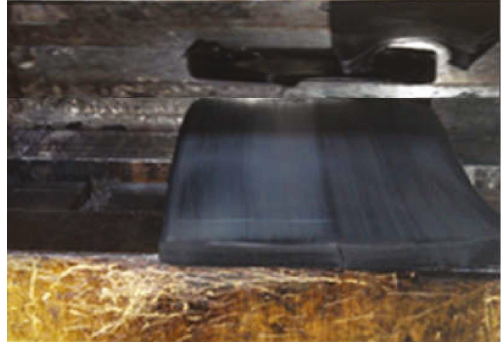
Figure 10: Extrusion state of rubber using optimal runner at 110 ° C and at 0.000345m 3 inlet fl ow